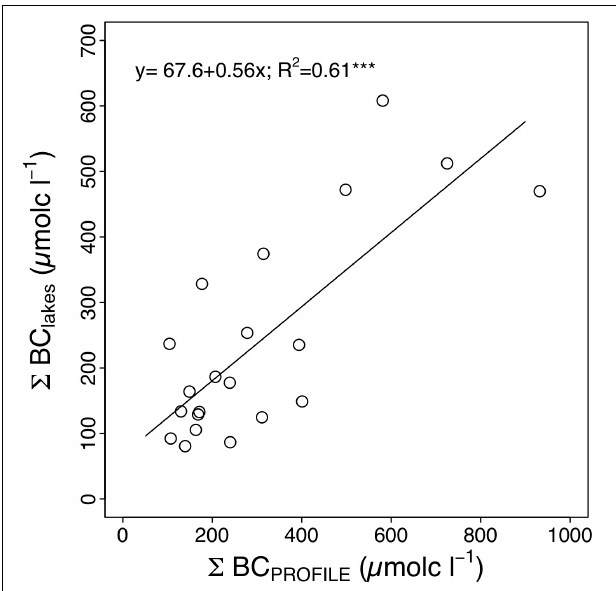
FIGURE 5 | Relationship between projected ( (cid:54) BC PROFILE ; µ mol c l − 1 ) base cation concentrations in the soil solution and measured base cation concentrations in lake water ( (cid:54) BC lakes ; µ mol c l − 1 ) at the study for the reference period